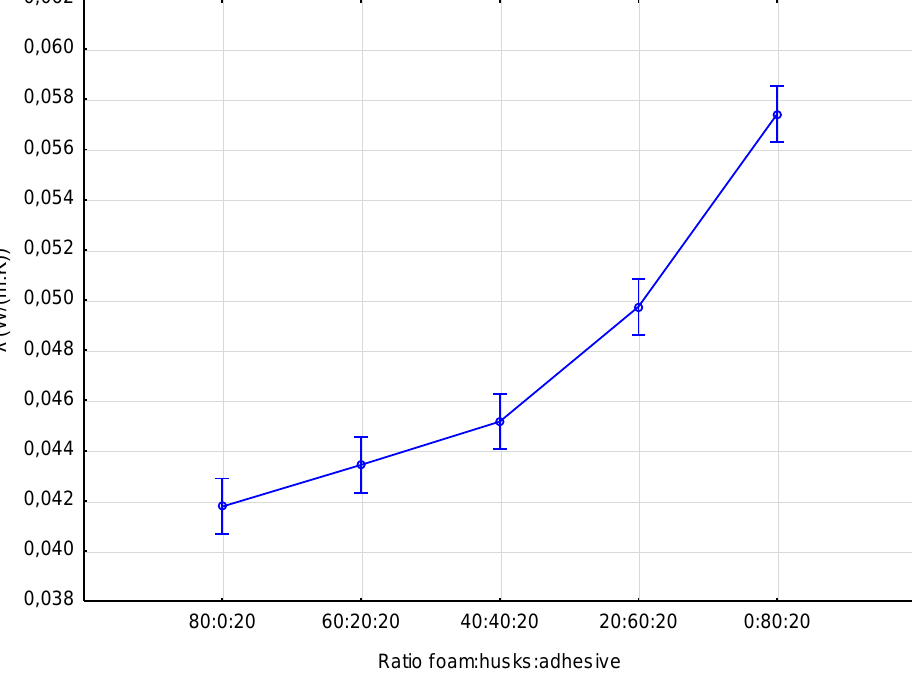
Figure 2. Influence of panel composition on the thermal conductivity coefficient. Table 4. p-values of Tukey post-hoc test: statistical significance of the differences in the graph in Figure 2.